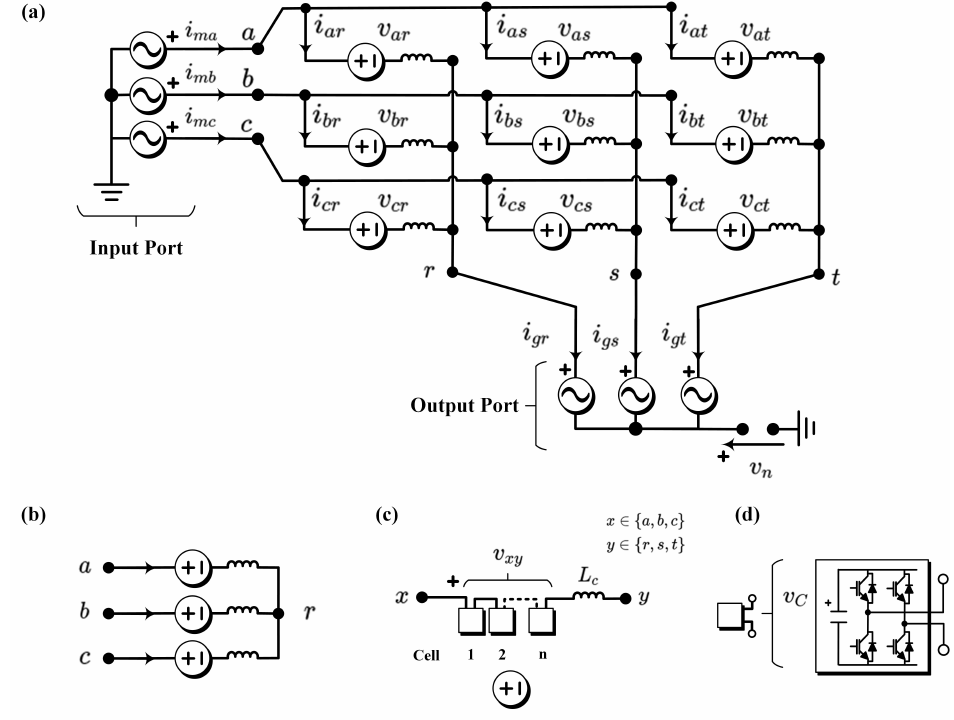
Figure 2. M 3 C topology. ( a ) Simplified circuit of the M 3 C . ( b ) Simplified circuit of a sub-converter. ( c ) Cluster. ( d ) Power-cell. Adapted from